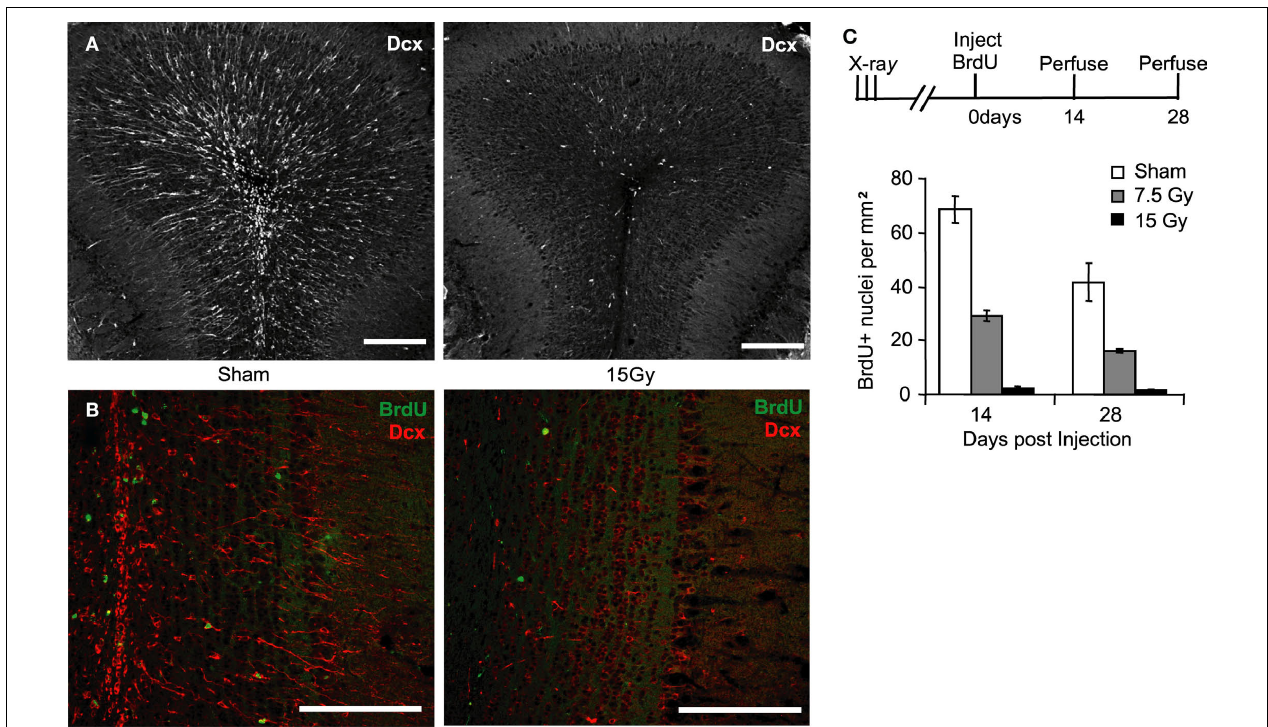
FIGURE 2 | Reduction in olfactory bulb neurogenesis is not accompanied by compensatory increase in new neuron survival. (A) The magnitude of olfactory bulb neurogenesis is qualitatively refl ected by the amount of dcx( + ) (Dcx) cells in the granule cell layer. (B) Quantifi cation of cell survival was done by counting BrdU( + ) nuclei, shown 4 weeks after irradiation. Scale bars: top 200 µm, bottom 50 µm. (C) Animals receiving SVZ irradiation (black) compared to non-irradiated controls (white) have an approximately 96% reduction in BrdU +